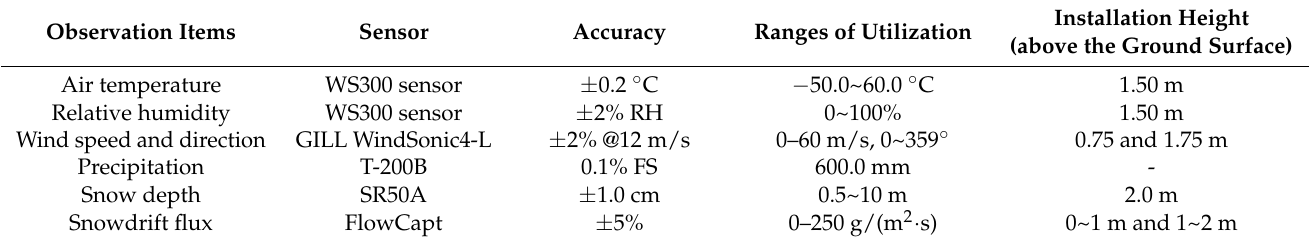
Table 1. Principal sensors and their respective accuracies operating at the Kayier snowdrift observa- tion